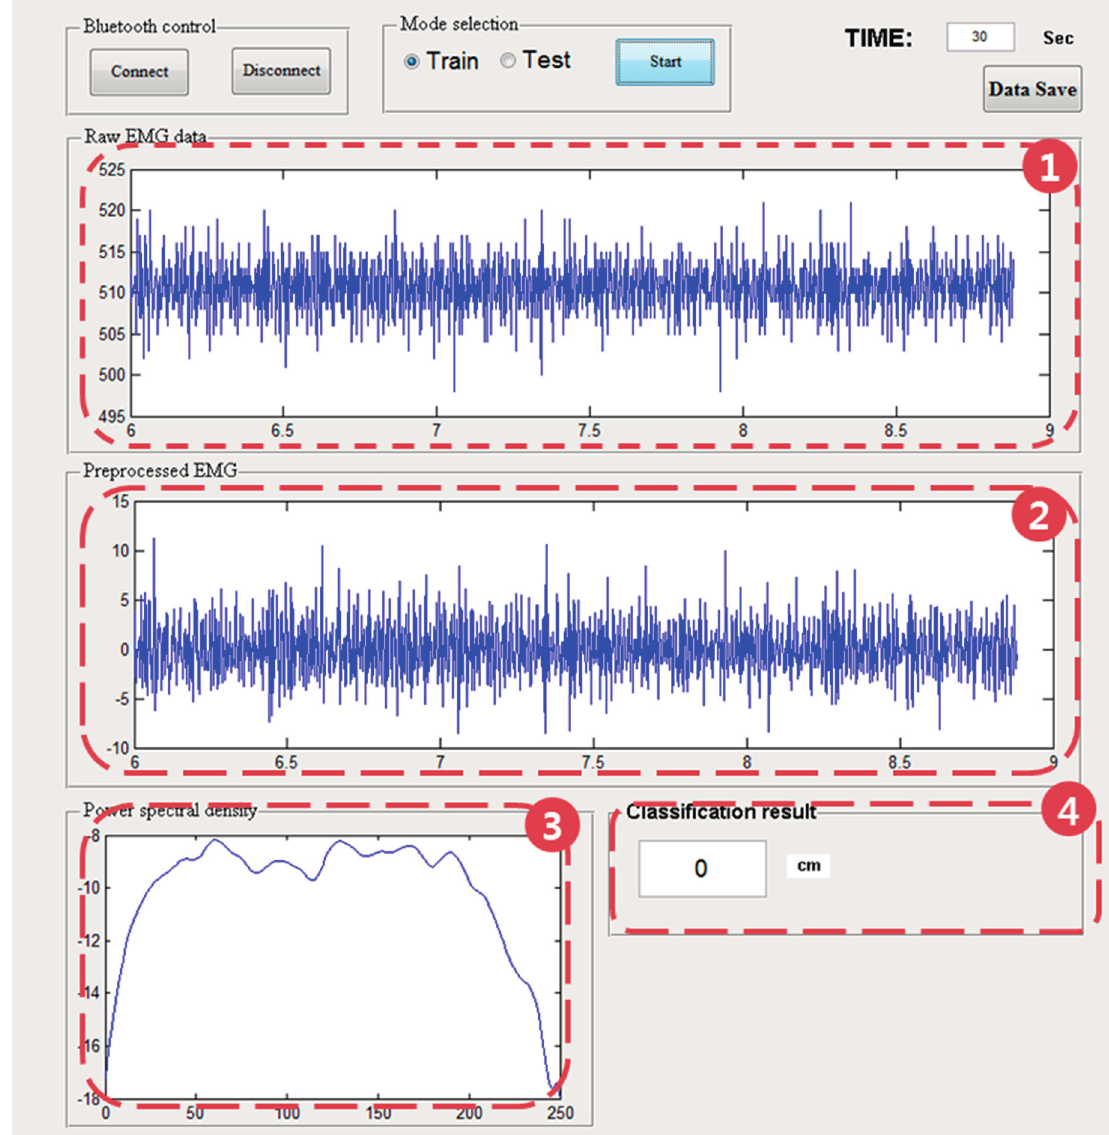
Figure 3. Graphic user interface (GUI) for our system. The GUI display (1) raw EMG; (2) preprocessed EMG; (3) power spectral density (PSD); and (4) the distance